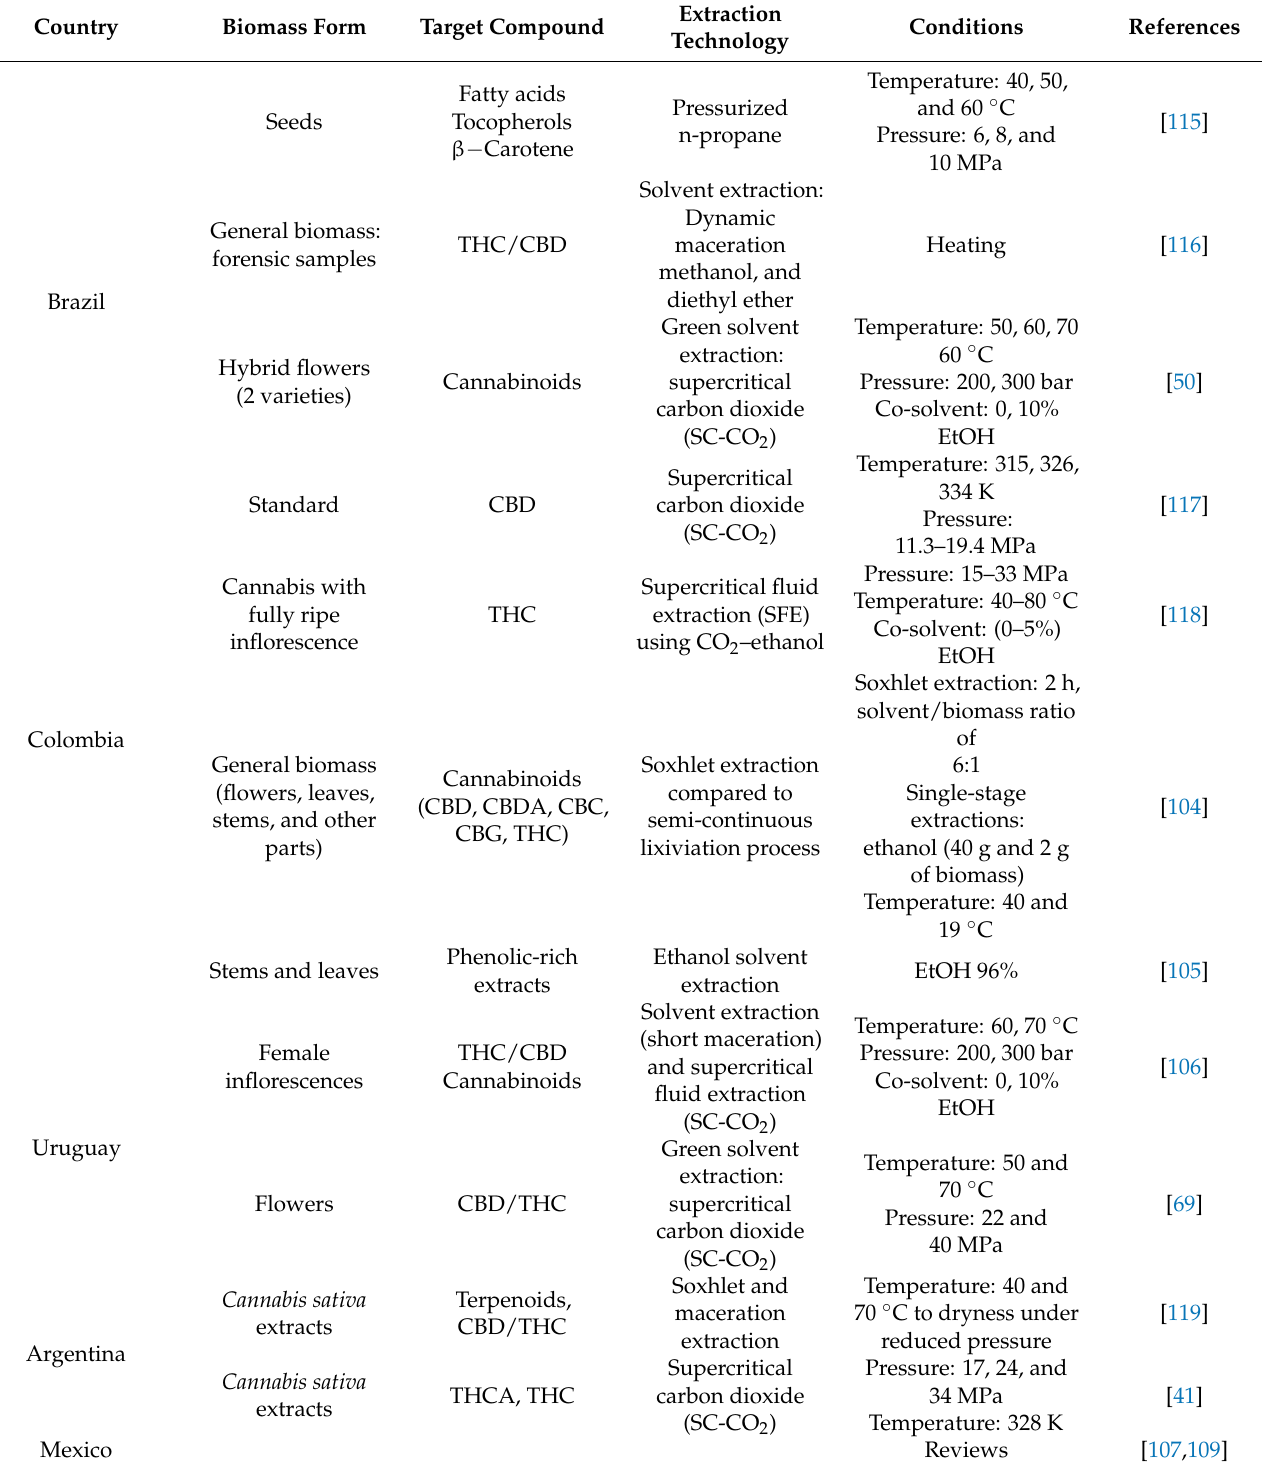
Table 3. Contribution to research on cannabis extraction technologies by Latin American